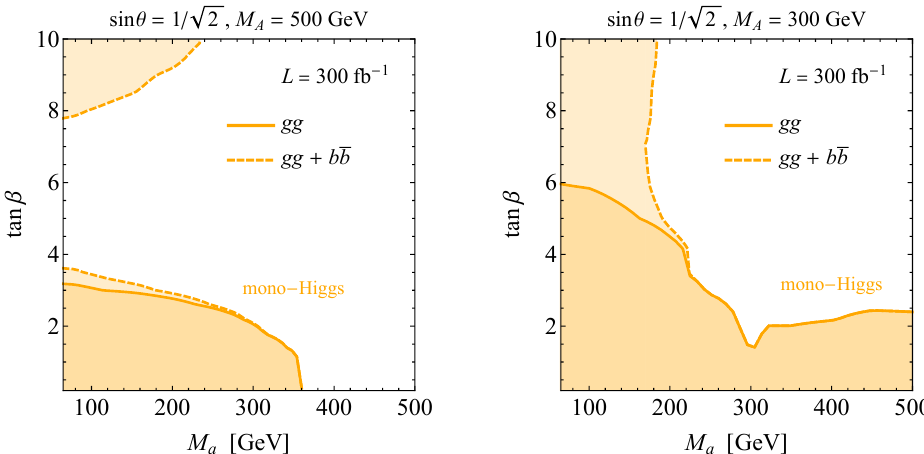
Figure 15 . 95% CL exclusion contours in our third and fourth benchmark scenario that follow from a hypothetical h + E T; miss (orange regions) search with 300 fb (cid:0) 1 of 13 TeV data. The solid lines correspond to the limits obtained from gg production alone, while the dashed curves include both the gg and b (cid:22) b initiated